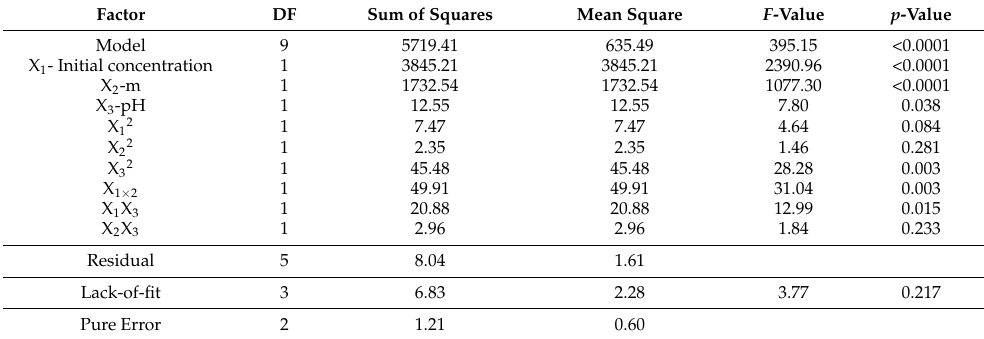
Table 5. ANOVA for the fit of the experimental results to response surface